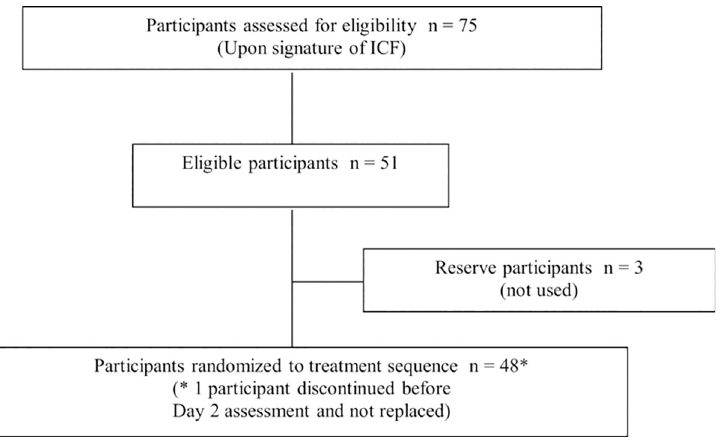
Fig 1. Flow diagram of participant distribution showing the number of participants assessed for eligibility enrolled and